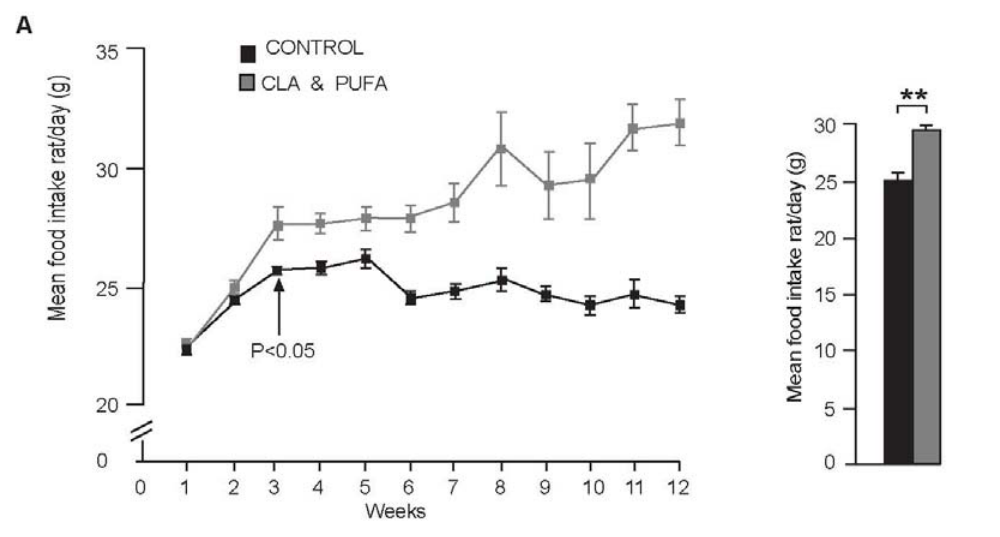
Figure 1. A. Mean food intake of rats receiving rat chow supplemented with either 2% vegetable oil (control) or 2% CLA plus n- 3 LC-PUFA. Mean daily intake per rat was calculated for each week to highlight when significant differences in food intake became apparent * P < 0.05 at three weeks. Daily food intake per rat was also calculated over the 12 weeks of the experiment ** P < 0.01 B. No significant difference (NS) was found in the body weights of the control supplementation vs . the CLA plus n- 3 LC-PUFA at any of the measurement points during the study or in the final body